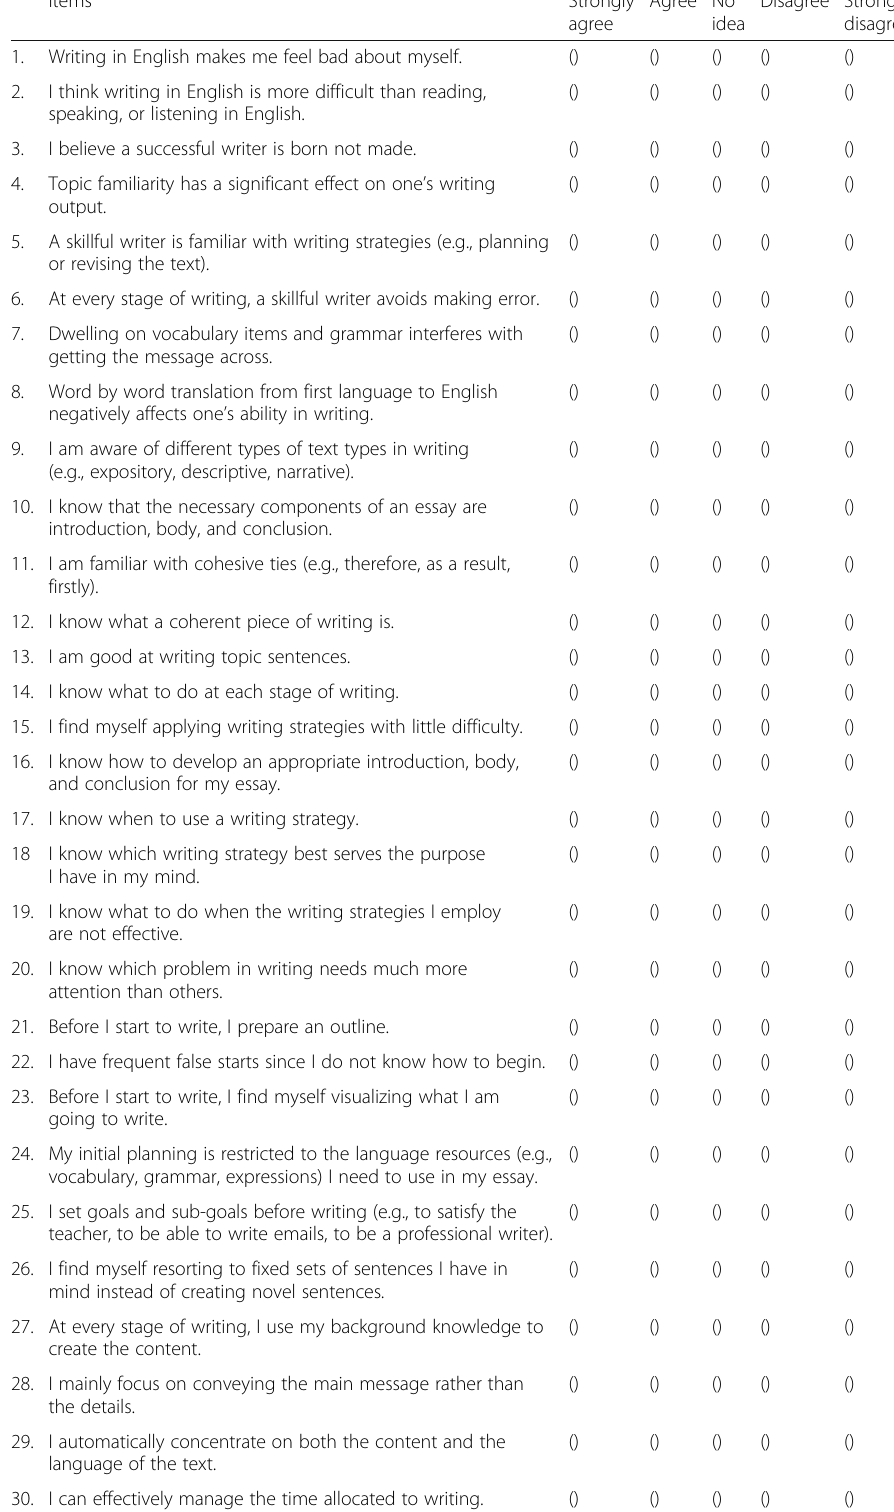
Table 7 MAWQ (Metacognitive Awareness Writing Questionnaire) Items Strongly